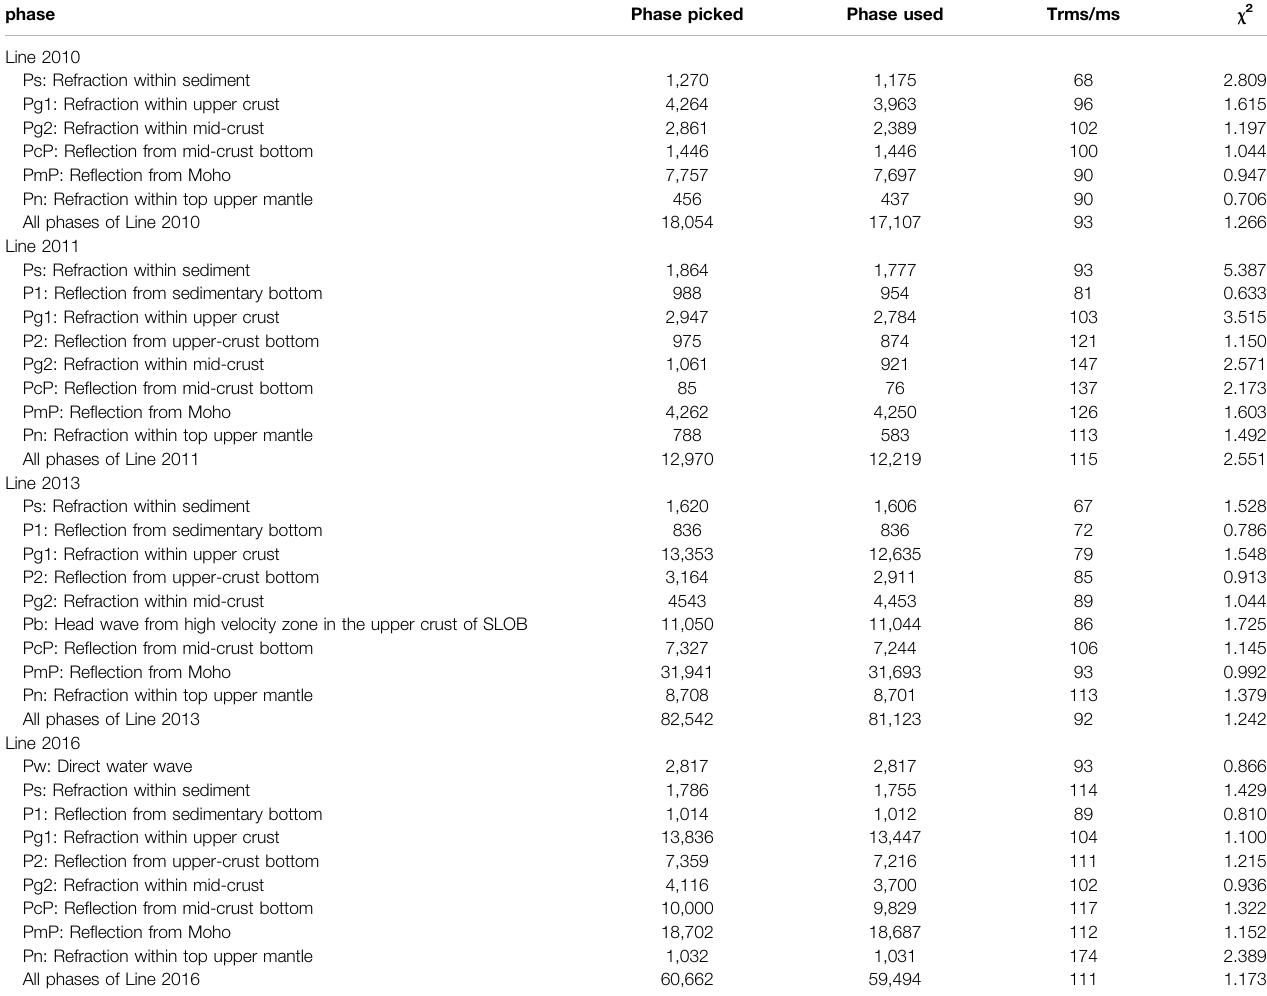
TABLE 2 | Number of picked and used phases in the forward modeling, and main uncertainties for the forward model phase Phase picked Phase